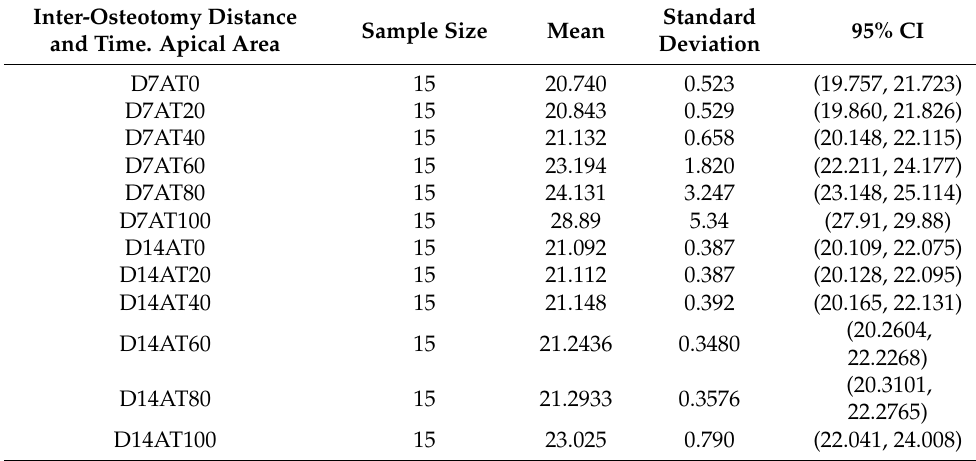
Table 3. Descriptive statistics of inter-implant bed temperature at distances of 7 mm and 14 mm in the apical area of the dense bone. D = distance, A = apical, T = time (T1 = 20 s, T2 = 40 s, T3 = 60 s, T4 = 80 s, T5 = 100